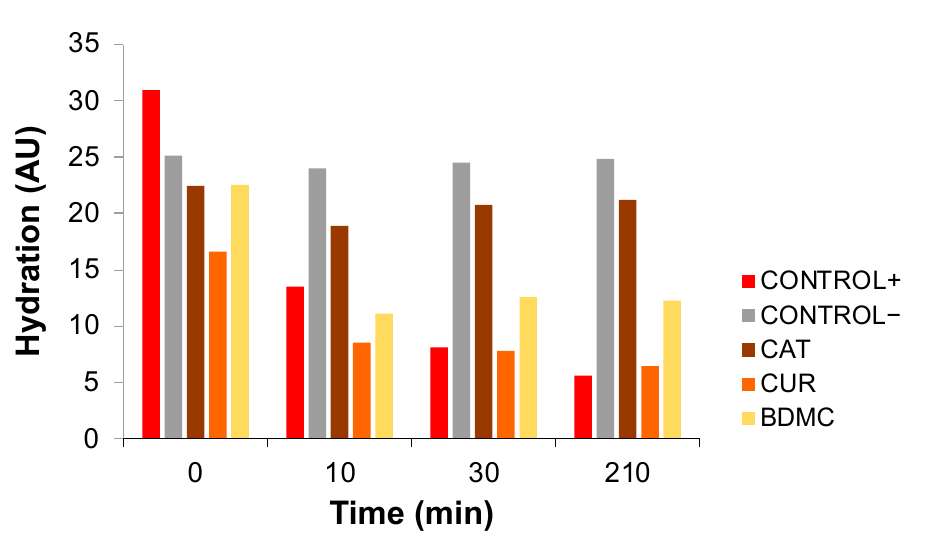
Figure 6. Median values of hydration (arbitrary units, AU) of the rats’ skin ( n = 6) after treatment with xylol and curcuminoids (CAT, CUR or BDMC). Rats treated with xylol but without curcuminoid were taken as Control+, whereas the ventral skin of rats treated only with ethanol was taken as Control − .